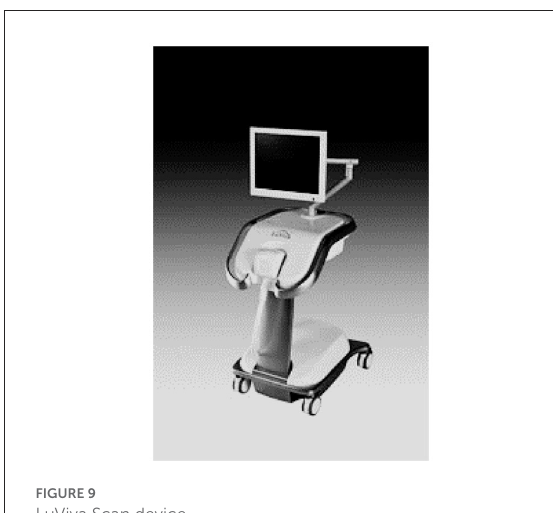
FIGURE9 LuViva Scan